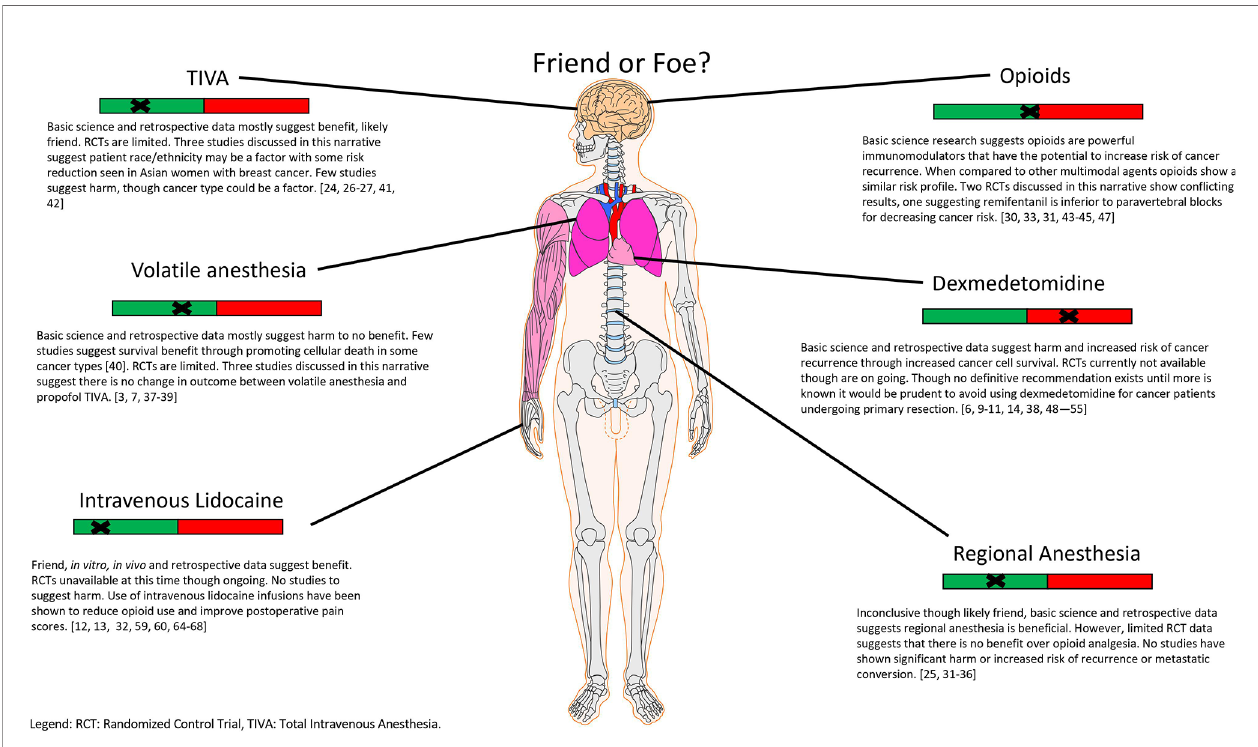
FIGURE 1 | A summary of fi ndings depicted in this narrative